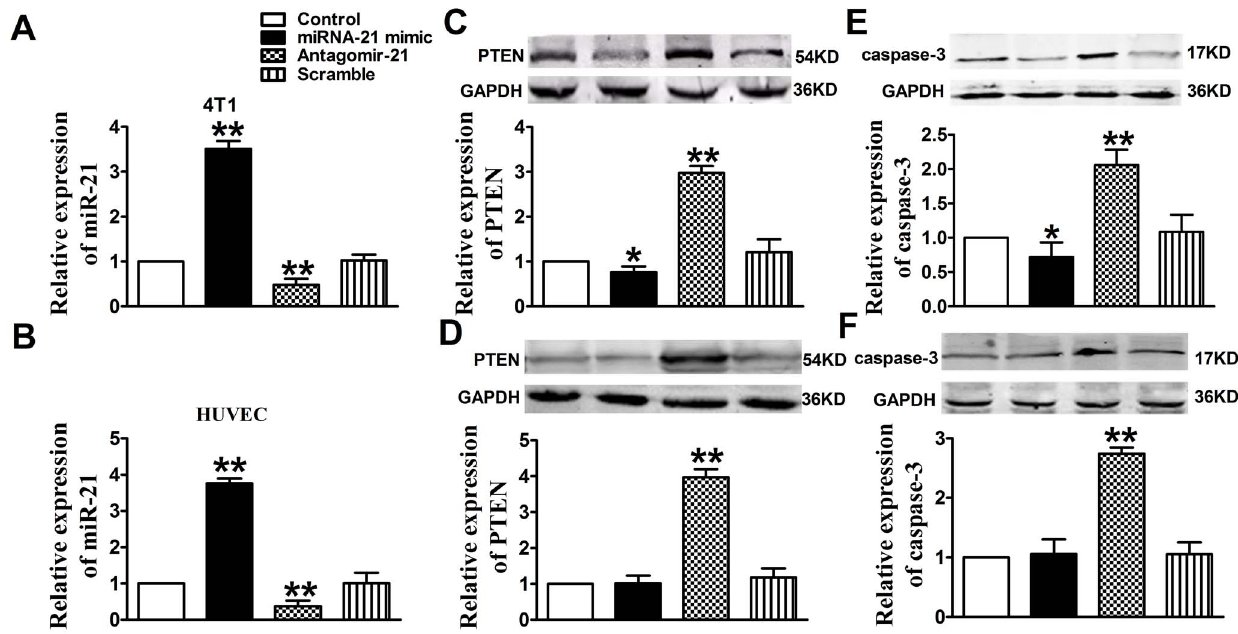
Figure 2. Down-regulation of miR-21 expression in 4T1 cells and HUVECs increased PTEN and Caspase-3 expression. Expression of miR-21 was showed in 4T1 cells (A) and HUVECs (B) that transfected with miR-21 mimic, antagomir-21, or scramble. Normal cells were used as control. Quantitative analysis of PTEN expression in 4T1 cells (C) and HUVECs (D). Quantitative analysis of Caspase-3 expression in 4T1 cells (E) and HUVECs (F). Proteins expression in normal cells, cells transfected with miR-21 mimic, antagomir-21 or scramble were examined by Western blotting. GADPH was used as an internal control. Data are mean 6 SEM, n=3, * P , 0.05, ** P , 0.01, as compared with control cells.